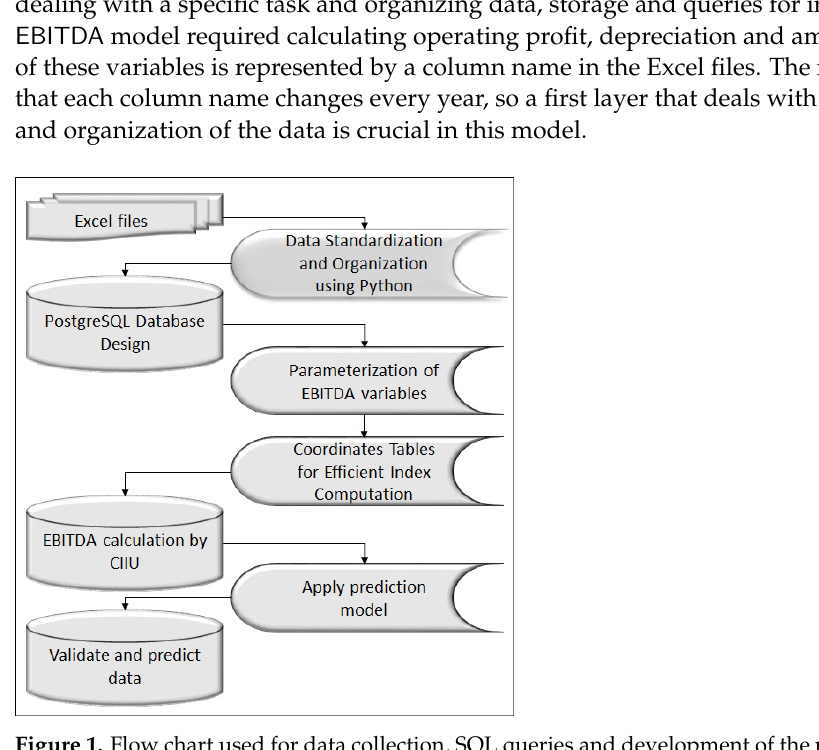
Figure 1. Flow chart used for data collection, SQL queries and development of the predictive analytic model based on the EBITDA